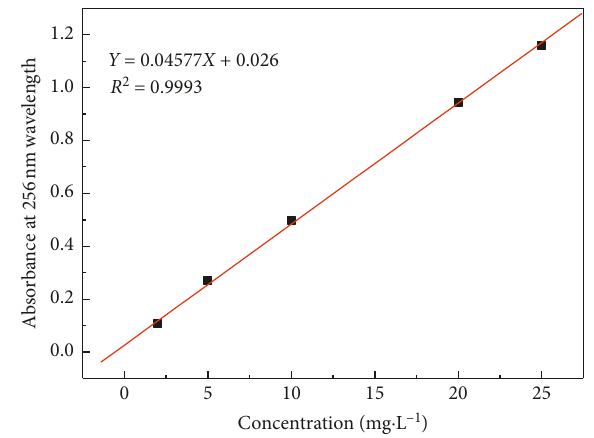
Figure 2: Standard curve of working of DDTC solution.